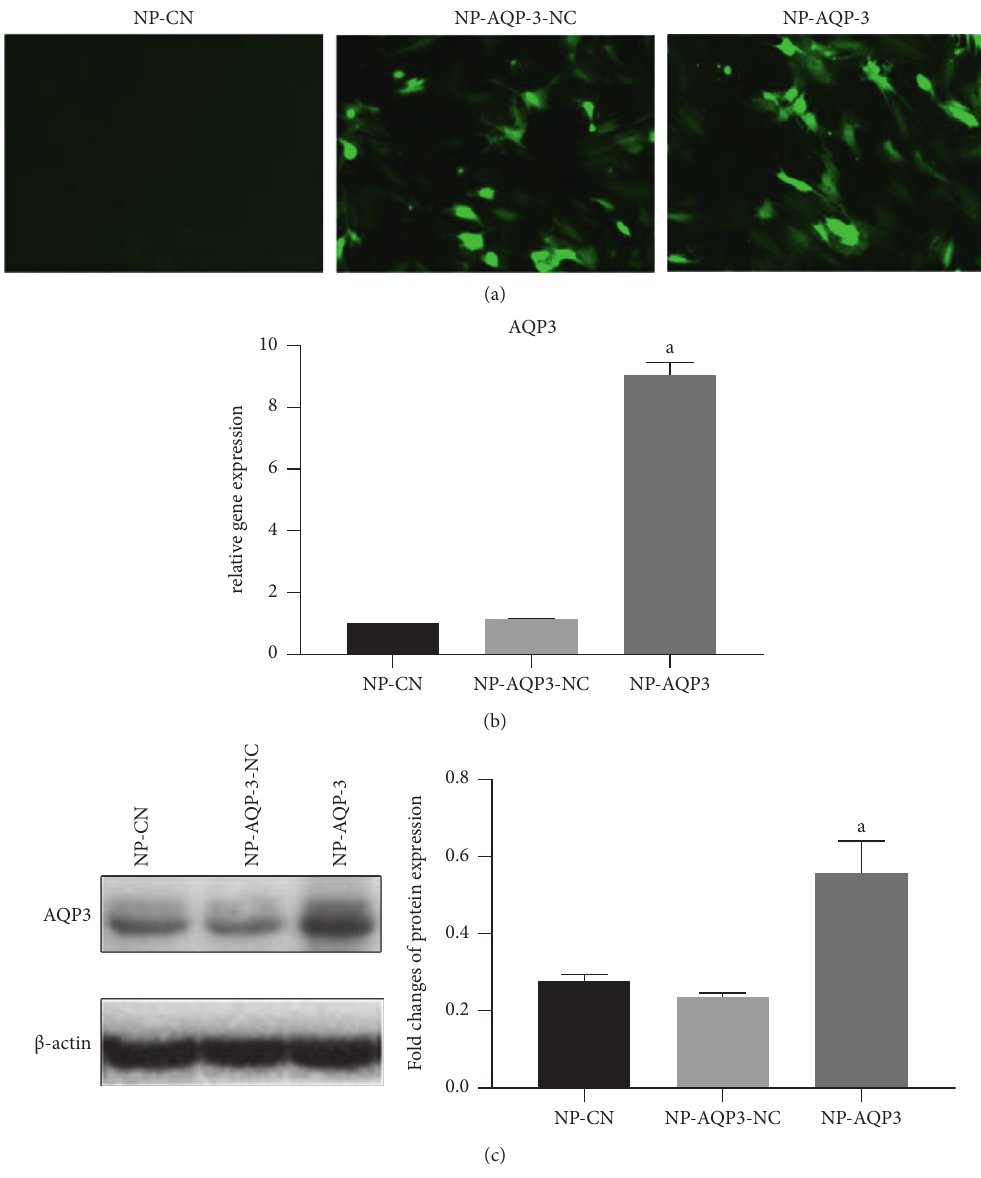
Figure 4: Verification of the efficacy of AQP-3 overexpression. (a) Observation of green fluorescent protein under an inverted fluorescence microscope. (b, c) Verification of the efficacy of AQP3 overexpression in NP cells using real-time PCR and western blotting assays. NP-CN: NP cells without transfection used as the controls. NP-AQP-3-NC: NP cells transfected with negative vectors. NP-AQP-3: NP cells with AQP-3 overexpression. Data are expressed as mean ± SD. (A) indicates a significant difference ( p < 0 . 05) when compared with the control